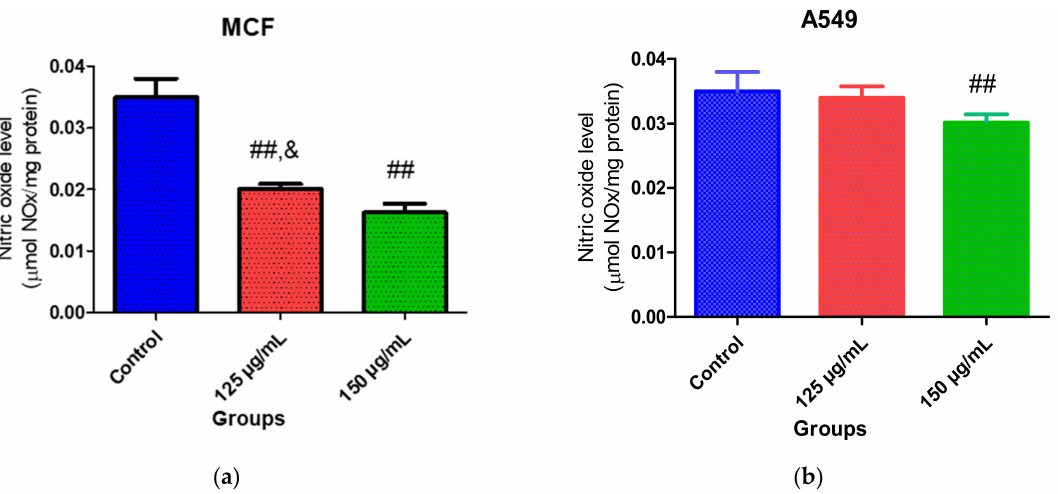
Figure 7. Effect of PUFA-rich extract from Chlorella sp. on NO levels in ( a ) MCF-7 and ( b ) A549 cells after incubation for 48 h. Bars represent mean ± SEM. Values are statistically different at ## p < 0.05 vs. control; & p < 0.05 vs. 150 µ